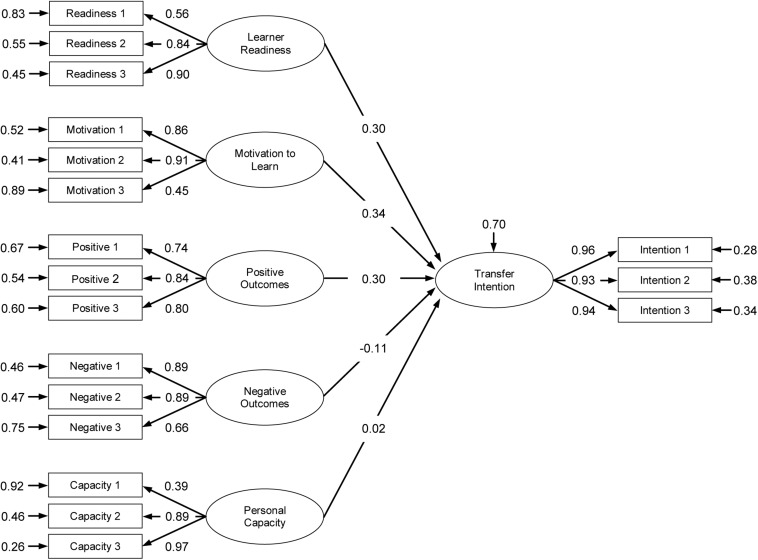
Measurement and structural model parameter estimates of transfer context: Study.